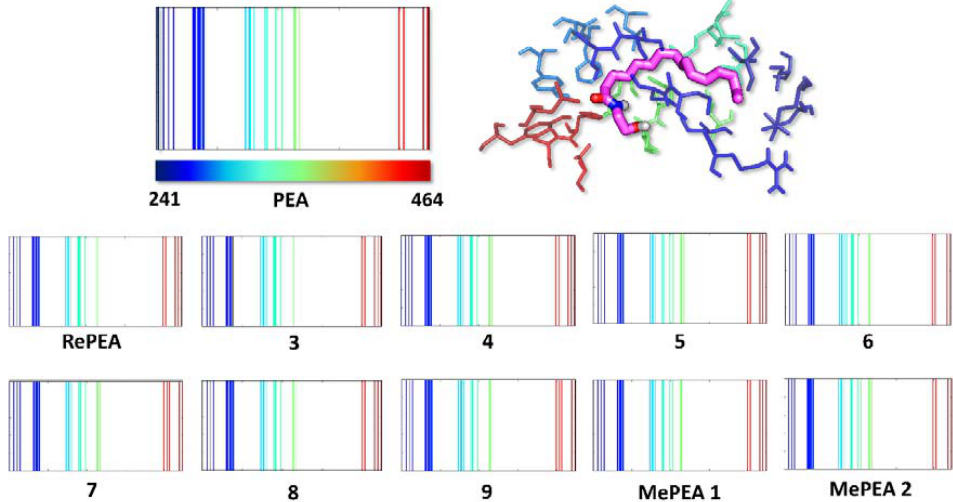
Figure 3. Structural Interactions Fingerprints (SIFs) of PEA and its analogues within the PPAR- α receptor. Each ligand is represented by a binary string encoding its interactions with the receptor residues, that are found between Ile241 and Tyr464. A solid ‐ colored line in the SIFs indicates that the ligand is involved in one (or more) interaction(s) with the residue of the corresponding color (from dark blue to dark red).